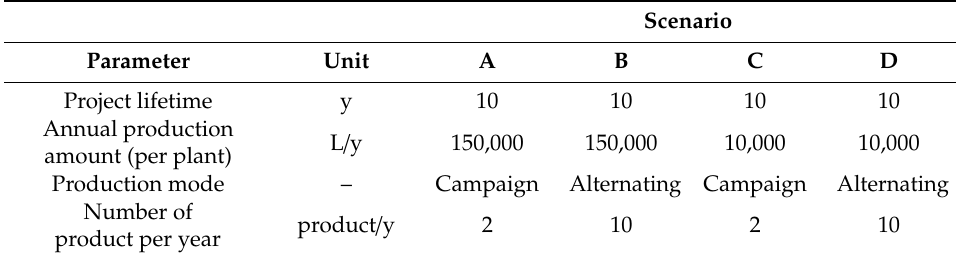
Table 4. Input parameters of each